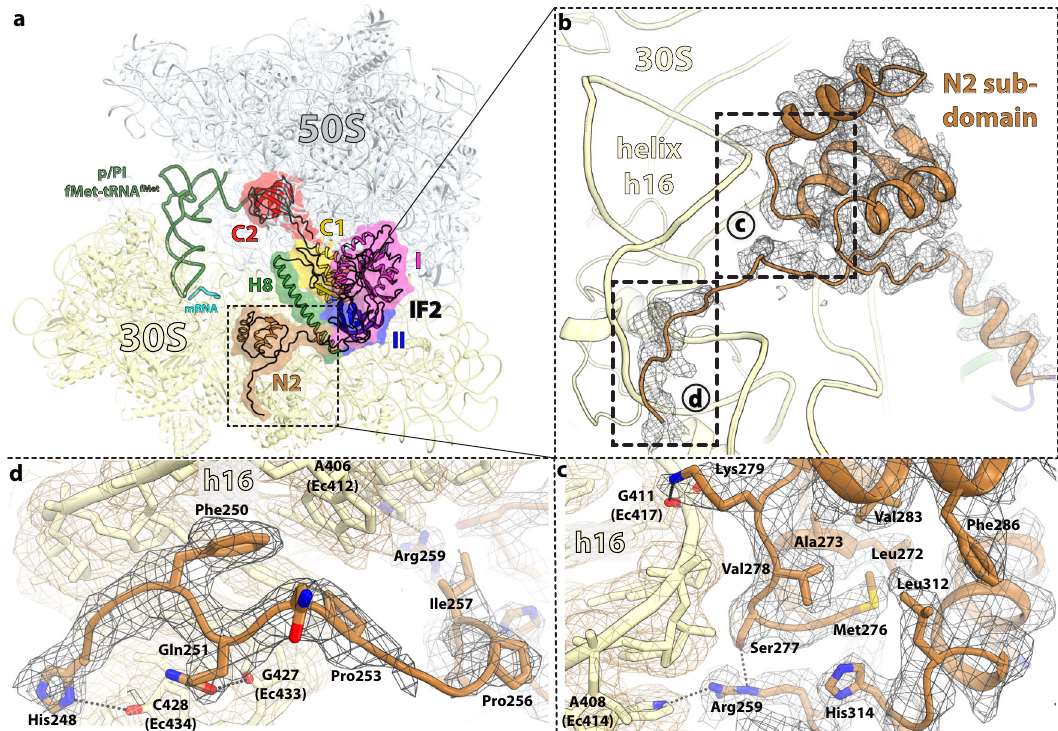
Fig. 7 Structure of the N2 sub-domain of IF2 in the 70S-IC. a Overview of extended IF2 in the 70S-IC with domains colored as in Fig. 1. The N2 sub- domain of IF2 (brown) interacts with the shoulder domain of the 30 S subunit. b Magni fi ed view of the N2 sub-domain bound to the shoulder region of the 30 S subunit. The locally re fi ned EM density map is shown as gray mesh. c , d Insets from panel b . c Interactions and surface complementarity between the N2-globular sub-domain of extended IF2 and helix h16 of 16 S rRNA. d The tail emerging from the N2 sub-domain of IF2 wraps around the minor groove of